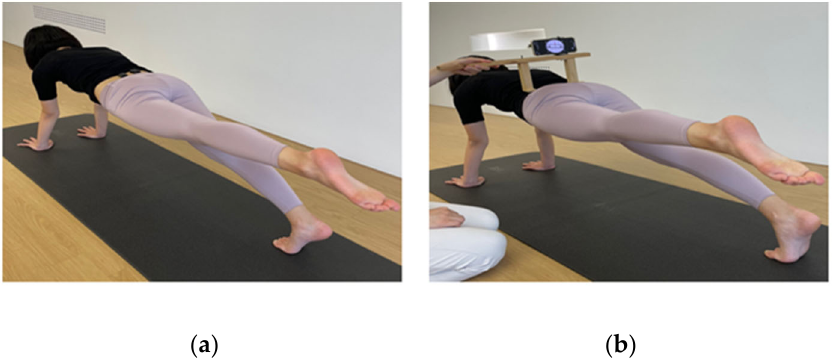
Figure 2. Measurement of muscle activity and pelvic rotation during LPF. ( a ) Measurement of muscle activity in the TrA/IO, EO, and MF; ( b ) measurement of pelvic rotation angle.